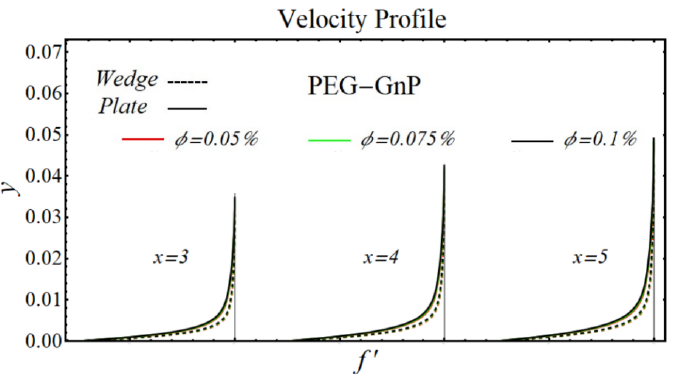
Figure 22. Velocity profile of PEG-TGr/DIW -nanofluids over the wedge and plate under the impact of nanoparticle volume fraction.